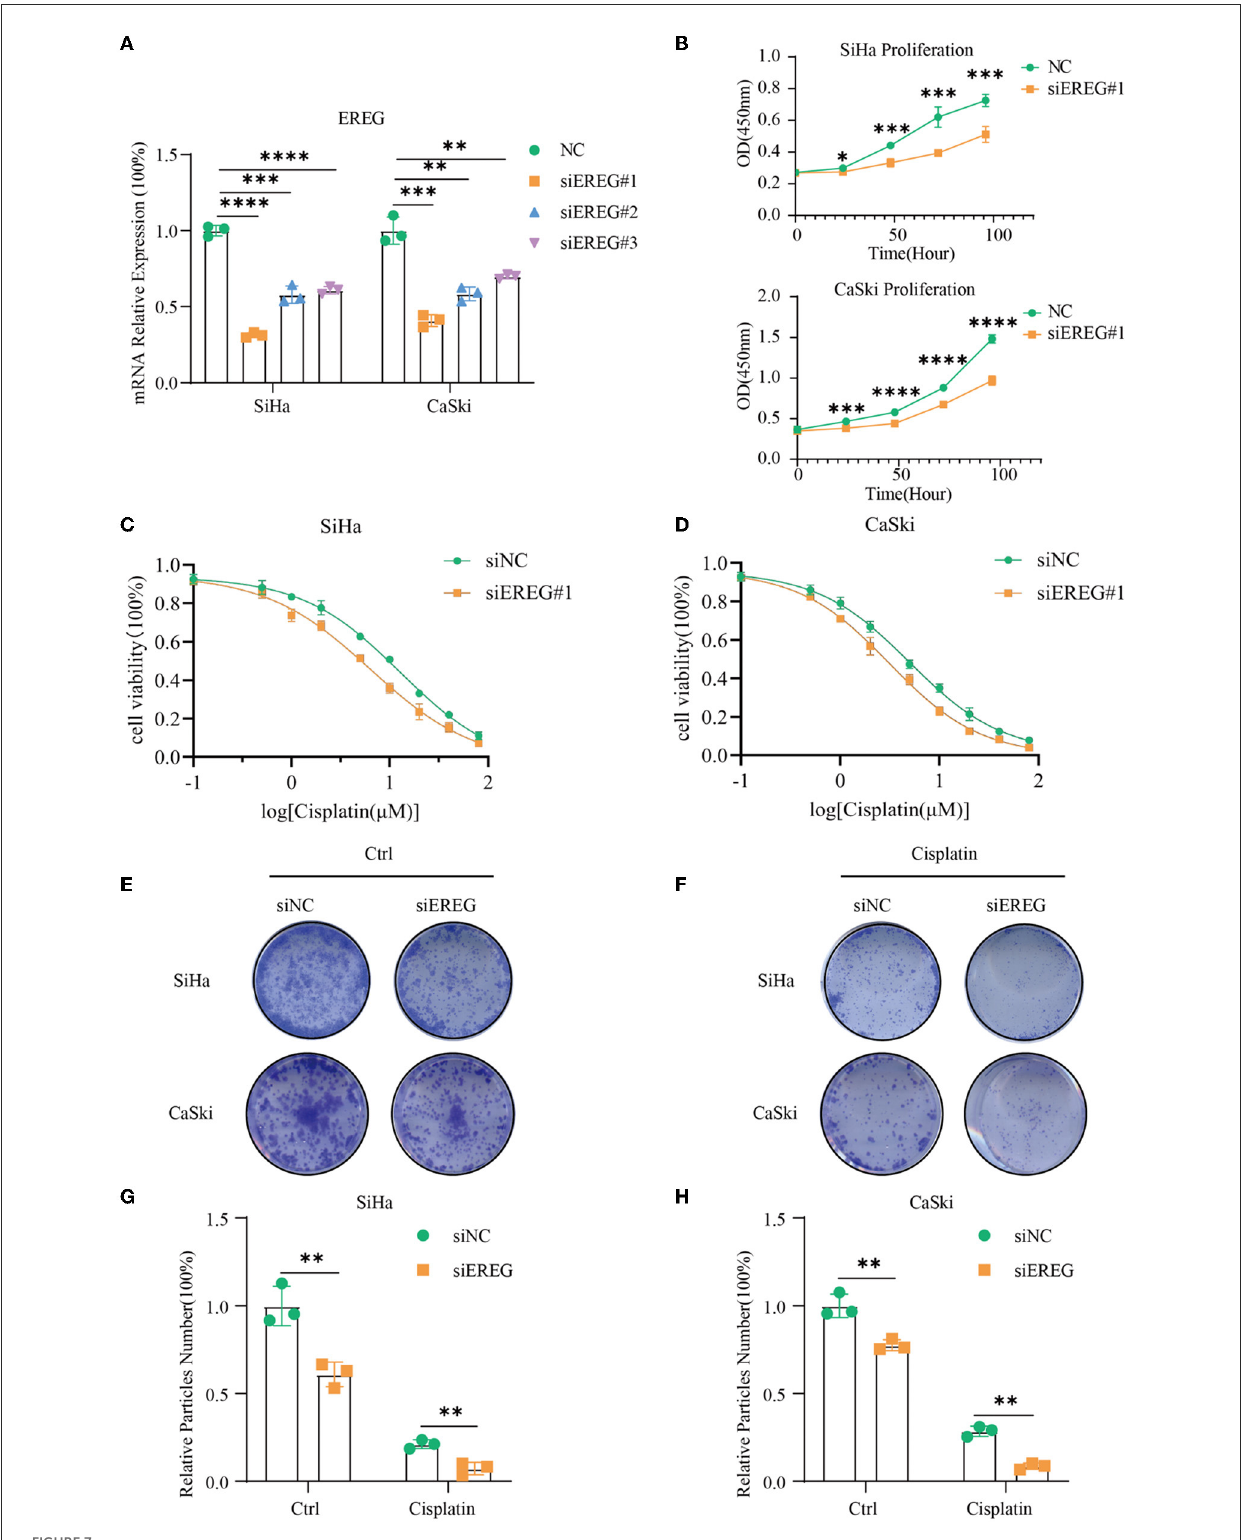
FIGURE7 The alterations in biological behavior when EREG was knocked down in cervical cancer. (A) Real-time PCR was used to detect mRNA levels in SiHa and CaSki cells transfected with siEREG at 48h. (B) The CCK8 cell viability curve was used to detect the proliferation of cervical cancer cells with different EREG expression levels. The CCK8 cell viability curve was used to detect the relative cell viability of SiHa (C) and CaSki cells (D) transfected with siEREG at different cisplatin concentration gradients after 48h. (E) The clone formation of SiHa and CaSki transfected with siEREG. (F) The clone formation of SiHa and CaSki transfected with siEREG was followed by cisplatin treatment for 48h. Histogram meant the relative clone particle numbers of SiHa (G) and CaSki (H) with or without cisplatin treatment. “*” represents p < 0.05, “**” represents p < 0.01, “***” represents p < 0.001, and “****” represents p <